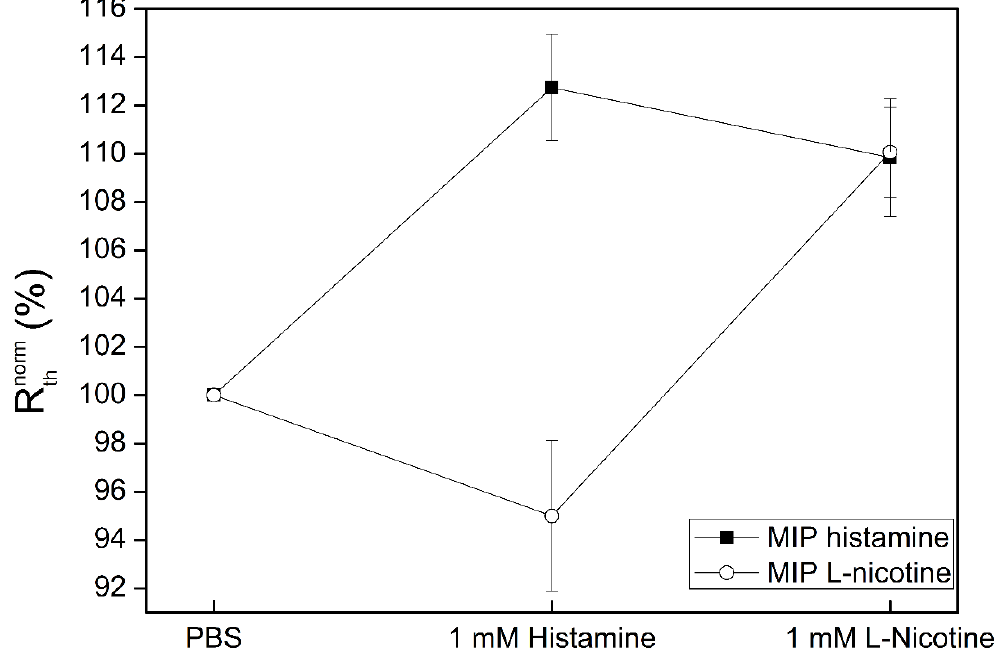
Figure 8. Thermal response curve of histamine and L -nicotine sensitive sensor spots upon exposure to a solution with a concentration of 1 mM histamine (first) and 1 mM L -nicotine (second) in PBS